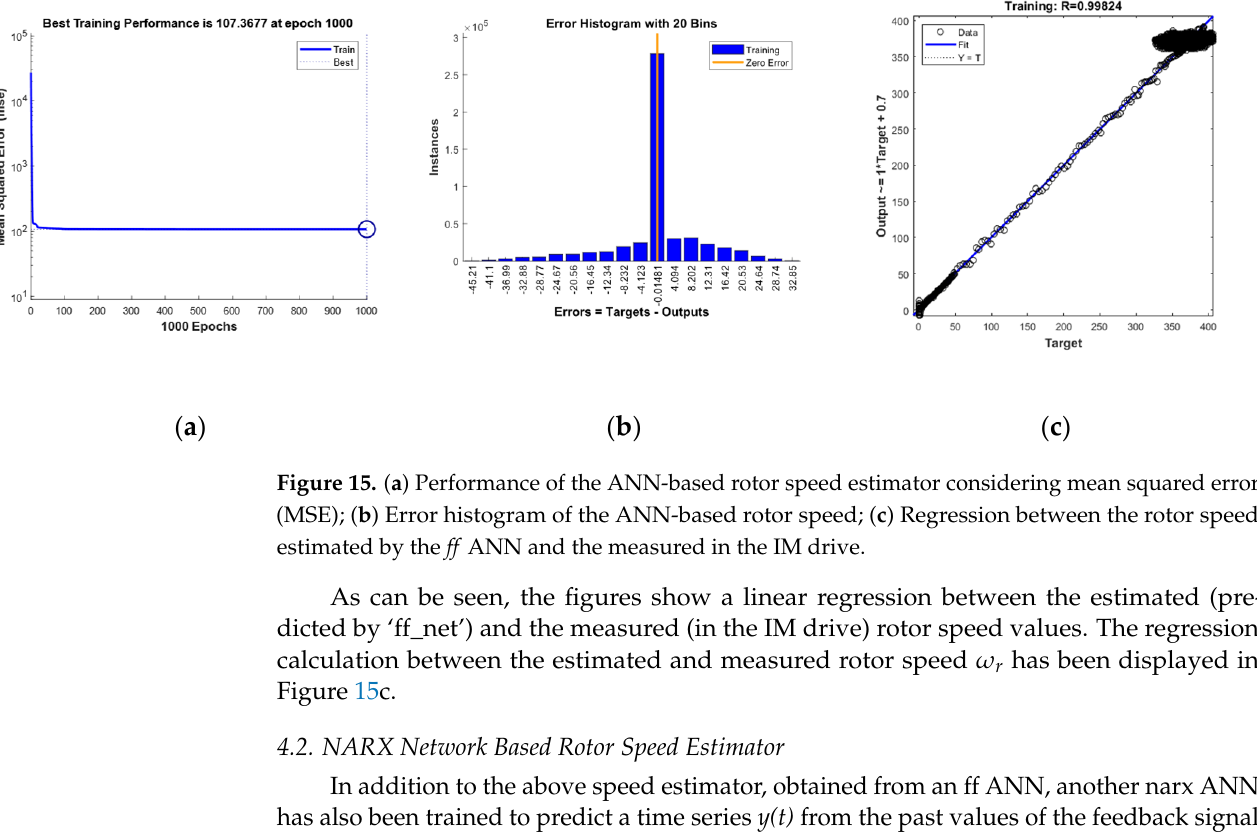
Table 3. Created narx ANN